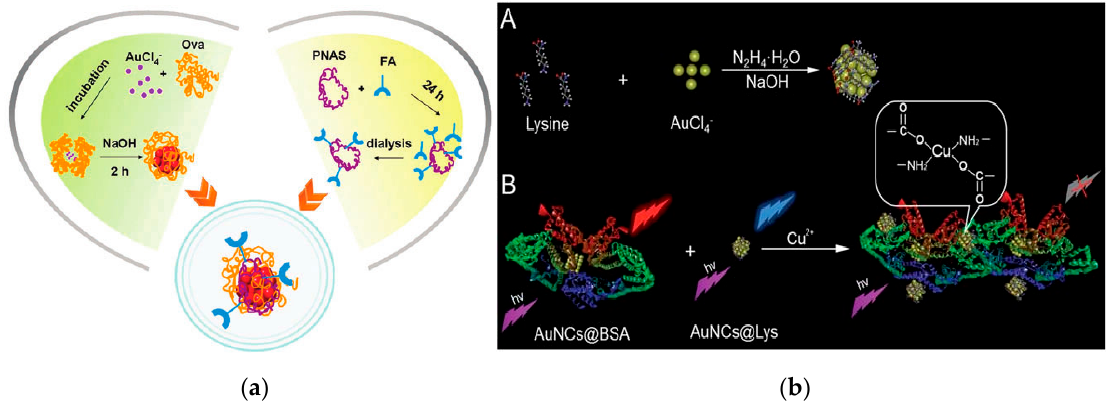
Figure 5. The proteins used as template molecule for metal NCs synthesis. ( a ) Schematic of the formation of AuNCs using ovalbumin as template. Reproduced with permission from [81]. Copyright